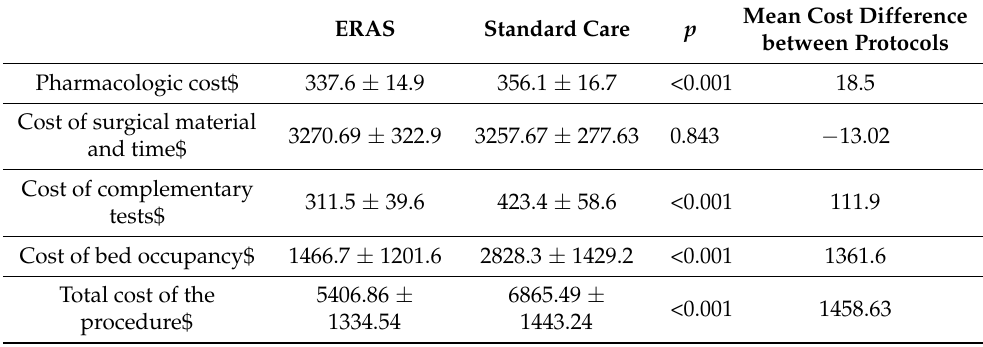
Table 5. Distribution of costs between groups. (Student’s t